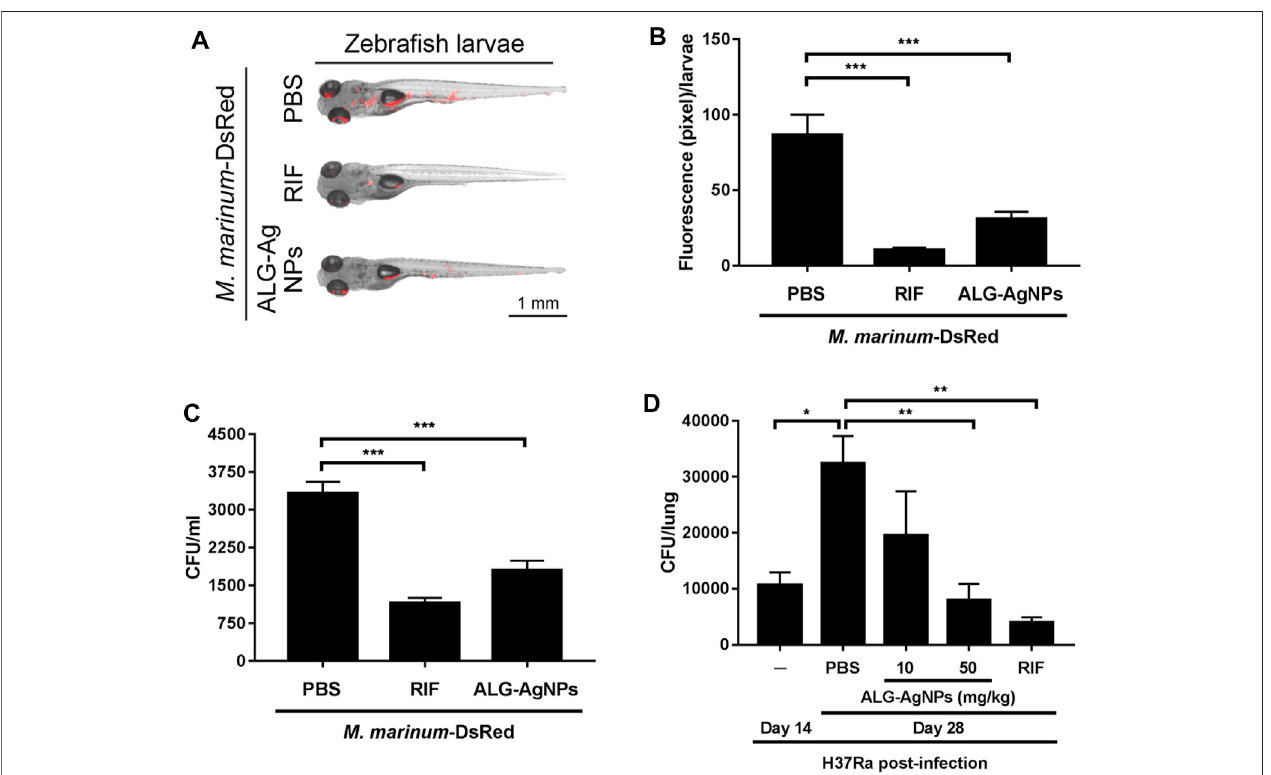
FIGURE7| ALG-AgNPs are asafe and effectivetherapeutic drug in zebra fi sh and mouse TBanimalmodels. (A – C) Aftermicroinjection of M. marinum -DsRed into the caudal vein of zebra fi sh larvae, the infected larvae (5 fi sh/group/experiment) were treated with PBS, 100 μ g/ml rifampicin (RIF) or 200 μ g/ml ALG-AgNPs for 5 days. All data for zebra fi sh were from two experiments. (A) At 5 days post infection (dpi), the red fl uorescence signal from M. marinum -DsRed infection was observed by fl uorescence microscopy. Scale bar represents 1 mm. (B) The fl uorescence signals of M. marinum -DsRed from zebra fi sh larvae treated with PBS ( n (cid:1) 10), rifampicin ( n (cid:1) 10) or ALG-AgNPs ( n (cid:1) 10) were quanti fi ed using ImageJ software and expressed as fl uorescence pixels per larvae. (C) For determination of bacterial burdens, fi ve fi sh/group/experiment were pooled together and homogenized in 1 ml PBS containing 1% SDS. The bacterial burdens of homogenates from infected larvaewerediluted10 × and100 × intriplicatesandenumeratedbyCFUanalysisoftwoexperiments. (D) BALB/cmicewereintravenouslyinfectedwith Mtb strainH37Ra for 14 days, then treated with PBS ( n (cid:1) 5), 10 mg/kg ( n (cid:1) 5) or 50 mg/kg ( n (cid:1) 5) of ALG-AgNPs, or 10 mg/kg rifampicin ( n (cid:1) 5) for another 14 days, then the mice were euthanized. The lungs of treated mice were collected and homogenized. The homogenates were plated on 7H10 agar plates. Bacterial growth in the lungs was determined by CFU analysis. Data in (B – D) represent mean ± SEM. * p < 0.05; ** p < 0.01; *** p < 0.001.